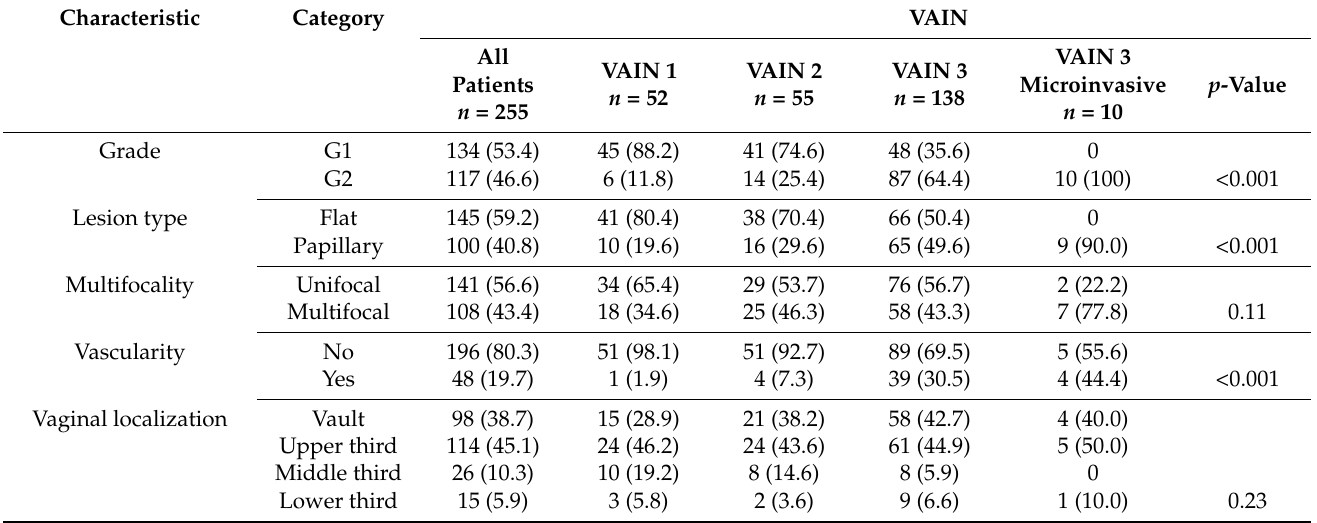
Table 3. Patients’ colposcopic features summary statistics a by VAIN grade at diagnosis, considering microinvasive VAIN3 as a separate